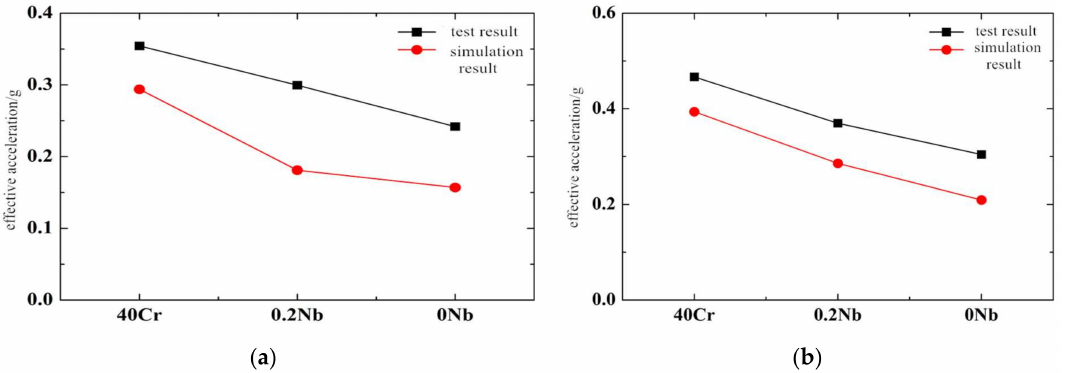
Figure 24. Comparison of experimental results and simulation results: ( a ) comparison of the results for measuring point 1 (Z); ( b ) comparison of the results for measuring point